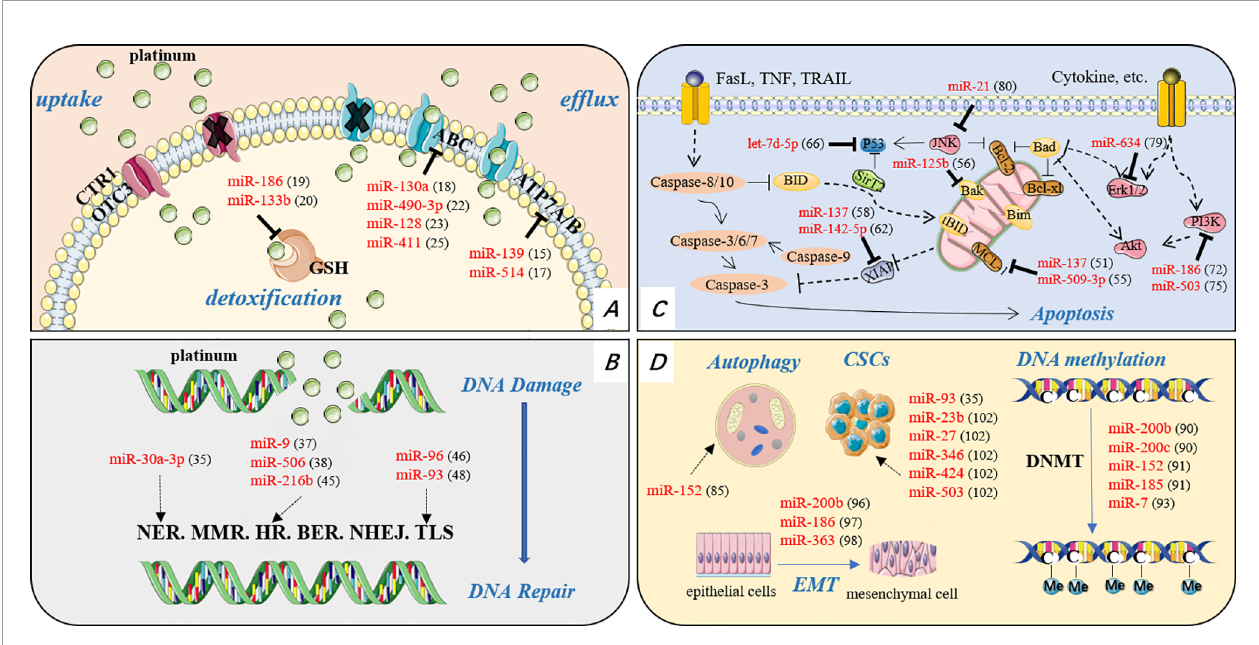
FIGURE 1 | The mechanism of platinum resistance in OC. (A) Reduced intracellular accumulation and cytosolic inactivation. (B) Increased DNA repair, including NER, MMR, HR, BER, NHEJ, and TLS. (C) Alteration of apoptosis related proteins and apoptosis associated pathways causing enhanced resistance to apoptosis. (D) Other cellular processes or pathways indirectly reduce platinum sensitivity. CTR1, copper transporter 1; OTC3, organic cation transporter 3; ABC, ATP-binding cassette transporter; ATP7A/7B, P-type ATPase transporter; GSH, glutathione; NER, nucleotide excision repair; MMR, mismatch repair; HR, homologous recombination; BER, base excision repair; NHEJ, non-homologous end joining; TLS, translesion synthesis; EMT, epithelial-mesenchymal transition; DNMT, DNA